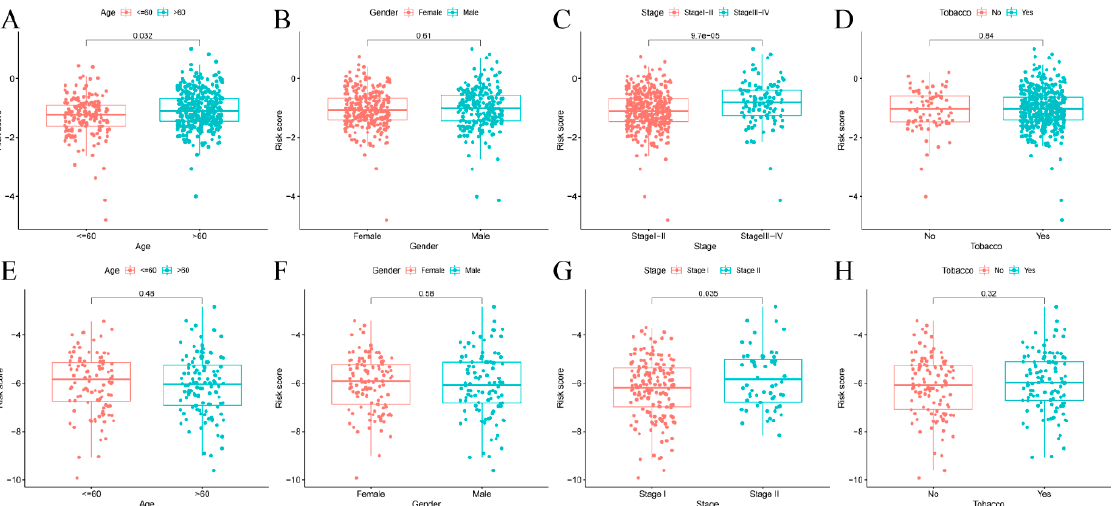
Figure 4. The risk scores of diverse groups were evaluated based on distinct clinical features. TCGA ( A – D ) and GEO ( E – H ) datasets. ( A , E ) Age. ( B , F ) Sex. ( C , G ) Tumor stage. ( D , H ) Tobacco.